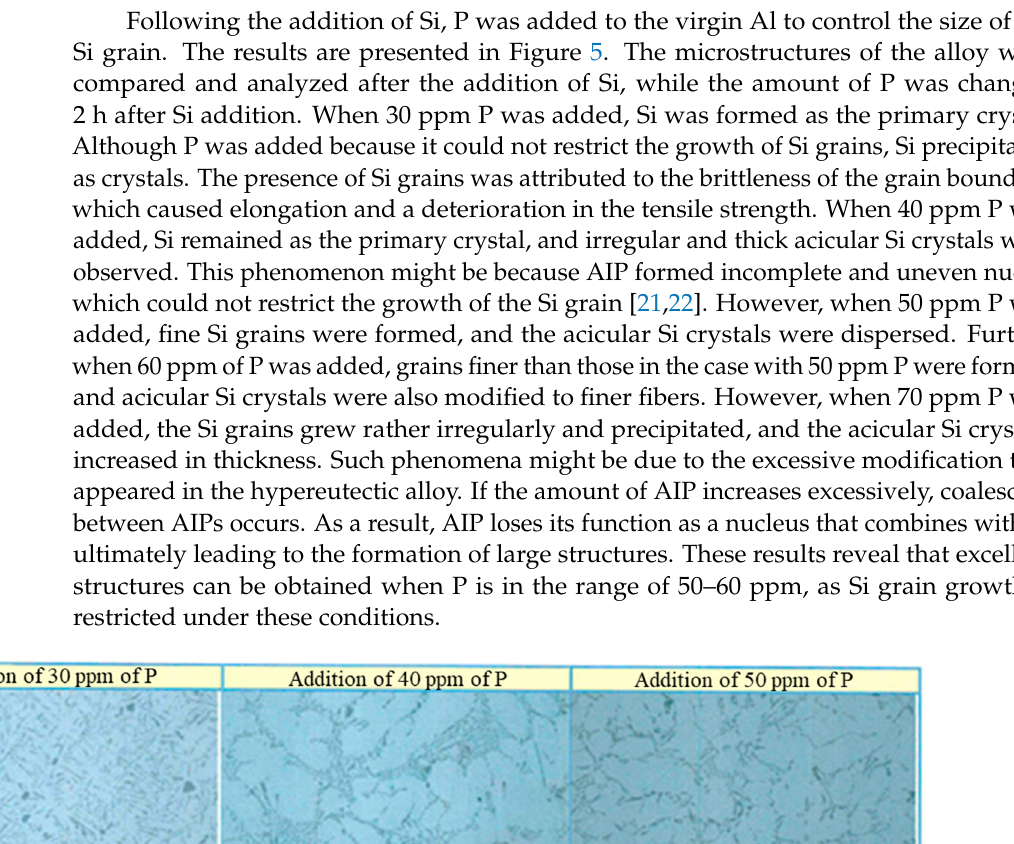
Figure 4. Changes in the microstructure with melting time after the addition of Si.